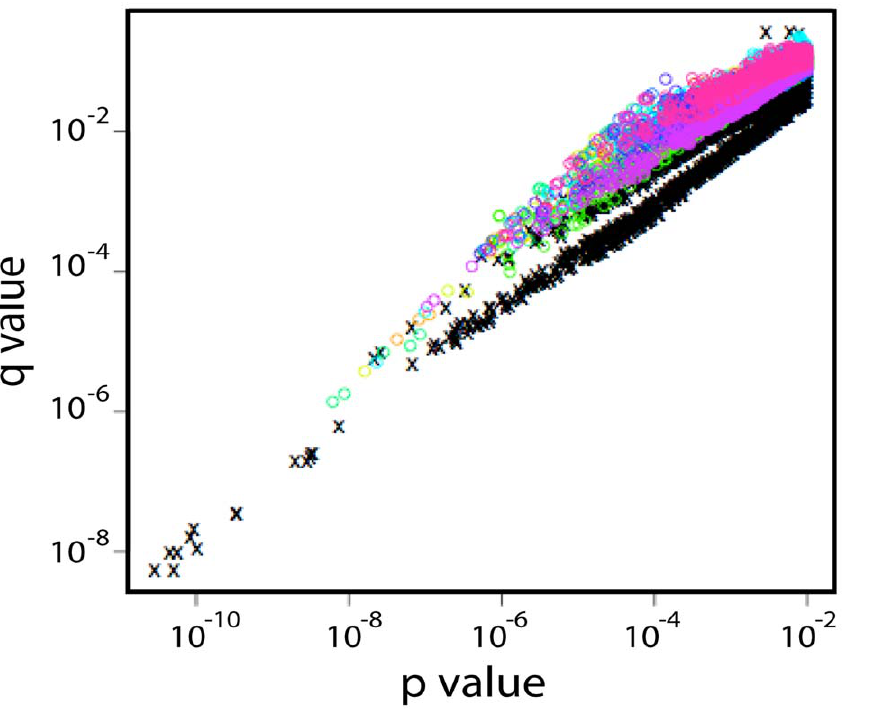
Figure 2. p- and q-values found in shuffling experiments in which the entire sequence signature strategy was repeated 10 times after randomizing the early and chronic designation of each subject. The black x’s represent the distribution of p- and q-values in the real data, while the colored circles represent the findings for incremental inclusion of Fiebig stages 2–6 in shuffled data. The lower quadrant of part of the graph is almost exclusively occupied by the real data, indicating a signature dependent on early versus chronic status; p-values of less than 10 2 6 were rare in the randomized data, and value less than 10 2 8 were exclusively found among real data classifications.